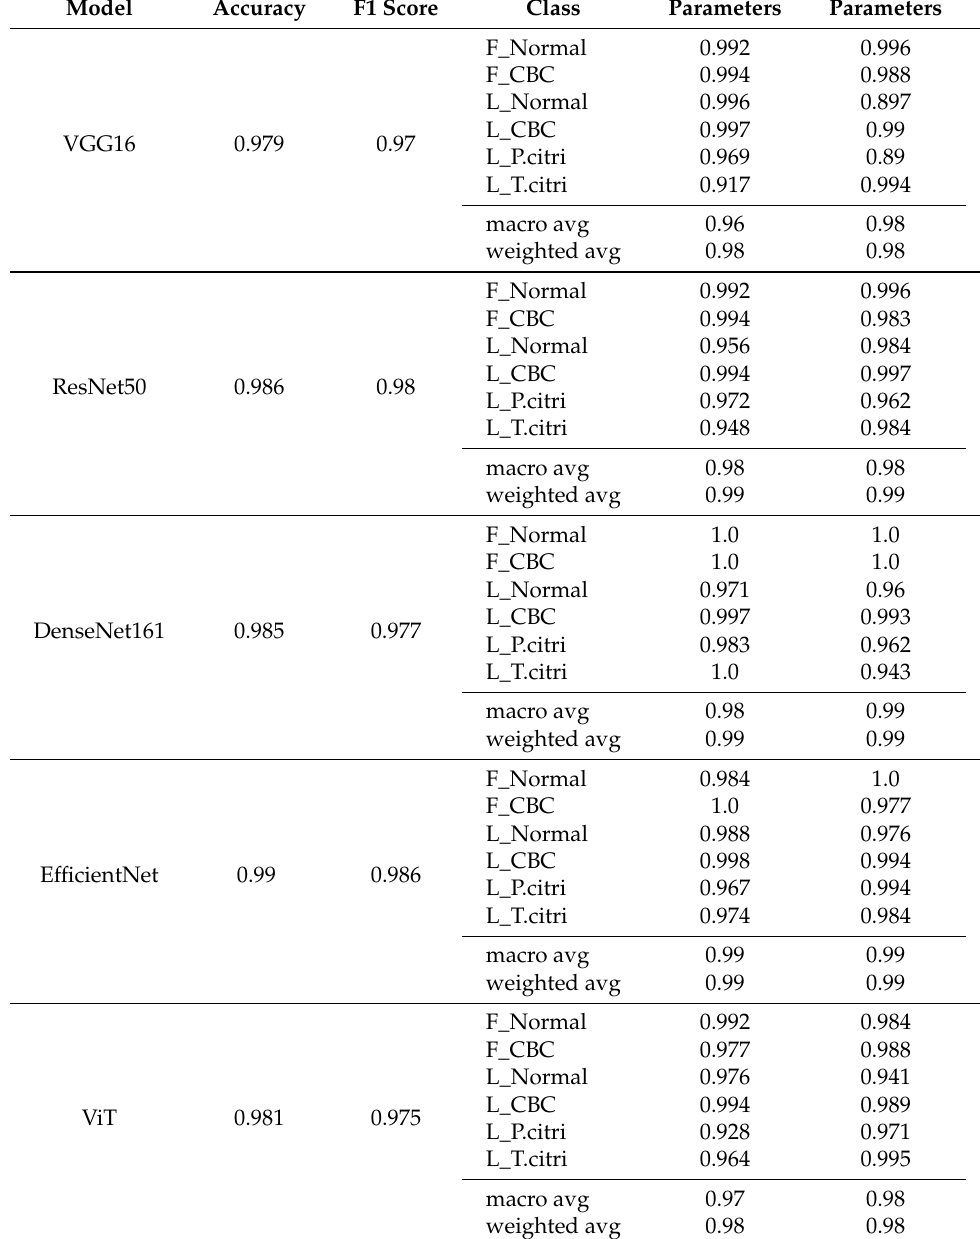
Table 4. Five model test classification performance of the citrus